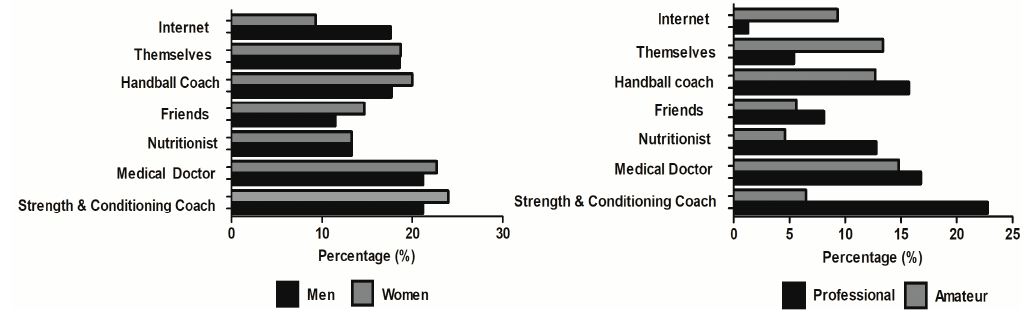
Figure 3. Sources of information when planning to use dietary supplementation in handball players according to sex (left panel) and competitive level (right panel).